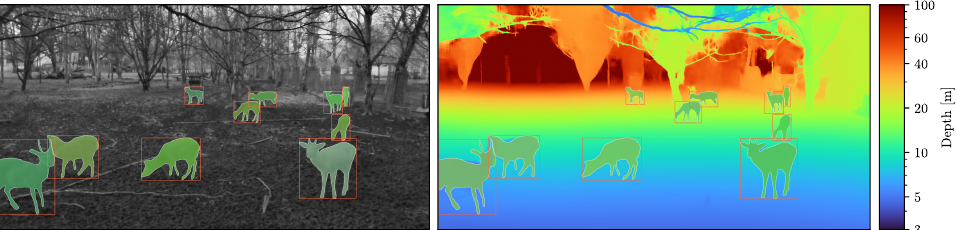
Figure 3. Examples of instance segmentation and bounding box annotations overlaid on top of the grayscale image of the left camera ( left ) and the color-coded depth map ( right ).